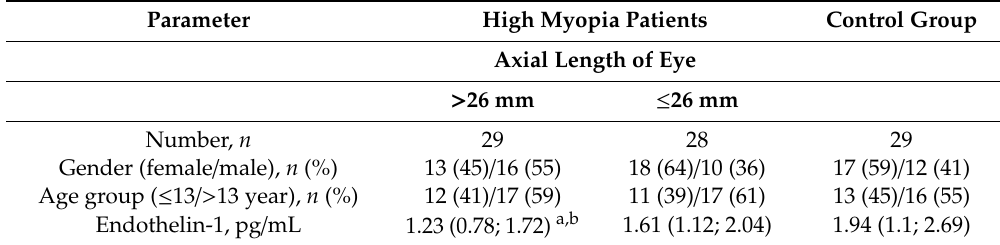
Table 3. Concentration of endothelin-1 in children and adolescents with high